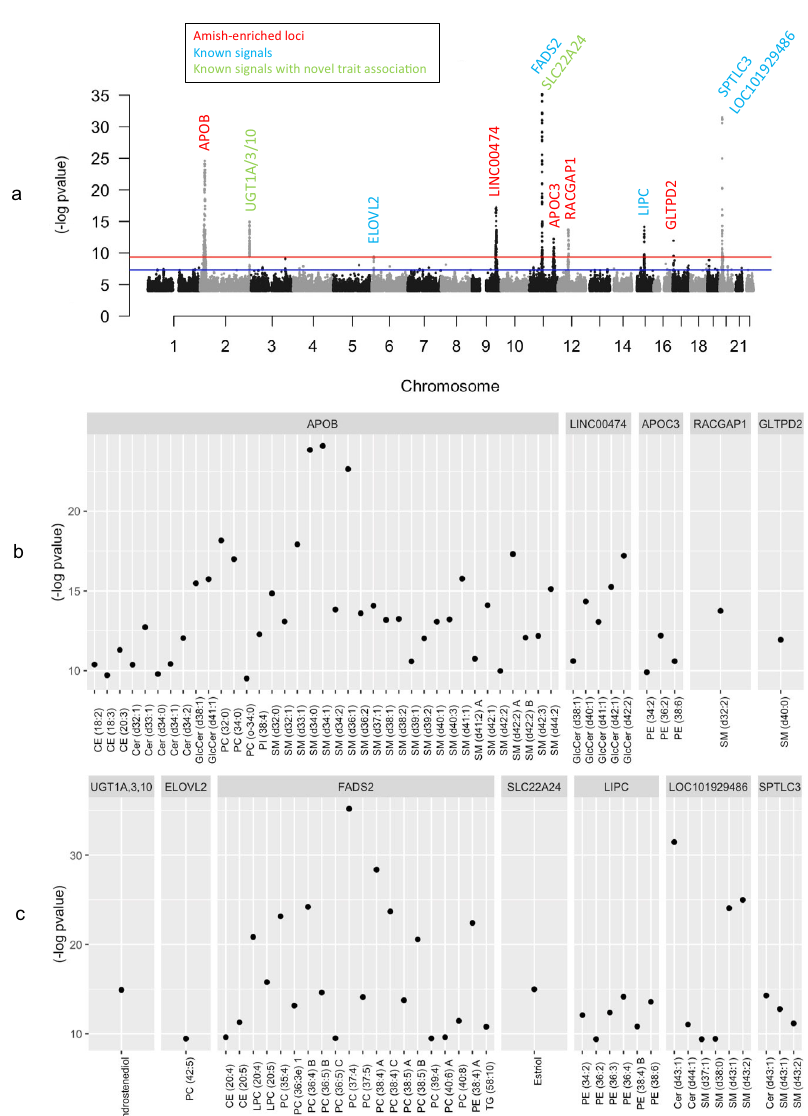
Fig. 3 Lipidomic association results. a Manhattan plot for the association results of all 355 lipid species in 639 Amish subjects. Amish-enriched loci denoted in red, previously known signals denoted in blue and previously known signals with novel trait association and/or novel variant in known loci in green. Blue line marks a genome-wide suggestive threshold (5.0E-08) and red line marks a genome-wide signi fi cant threshold (4.5E-10). b GWAS results for all signi fi cantly associated lipid species in Amish-enriched loci. c GWAS results for all signi fi cantly associated lipid species in previously known loci. All p -values based on t-test using additive genetic model. CE Cholesteryl ester, Cer Ceramide, GlcCer Glycosphingolipids, PC Phosphatidylcholines, PE Phosphatidylethanolamine, SM